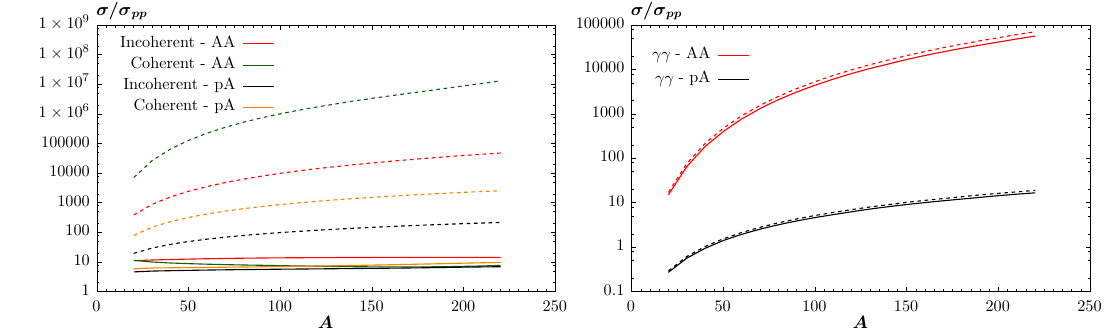
√ Fig. 5 Ratio of cross sections at s = 5 . 02 TeV in proton–ion ( pA ) without survival effects are shown by the solid (dashed) lines. Note that andion–ion( AA )collisionstotheproton–protonresult.TheQCD(pho- for the QCD-initiated production the survival factor due to the partici- ton) initiated cases are shown in the left (right) plots. Results with and pating nucleon pair is included in all